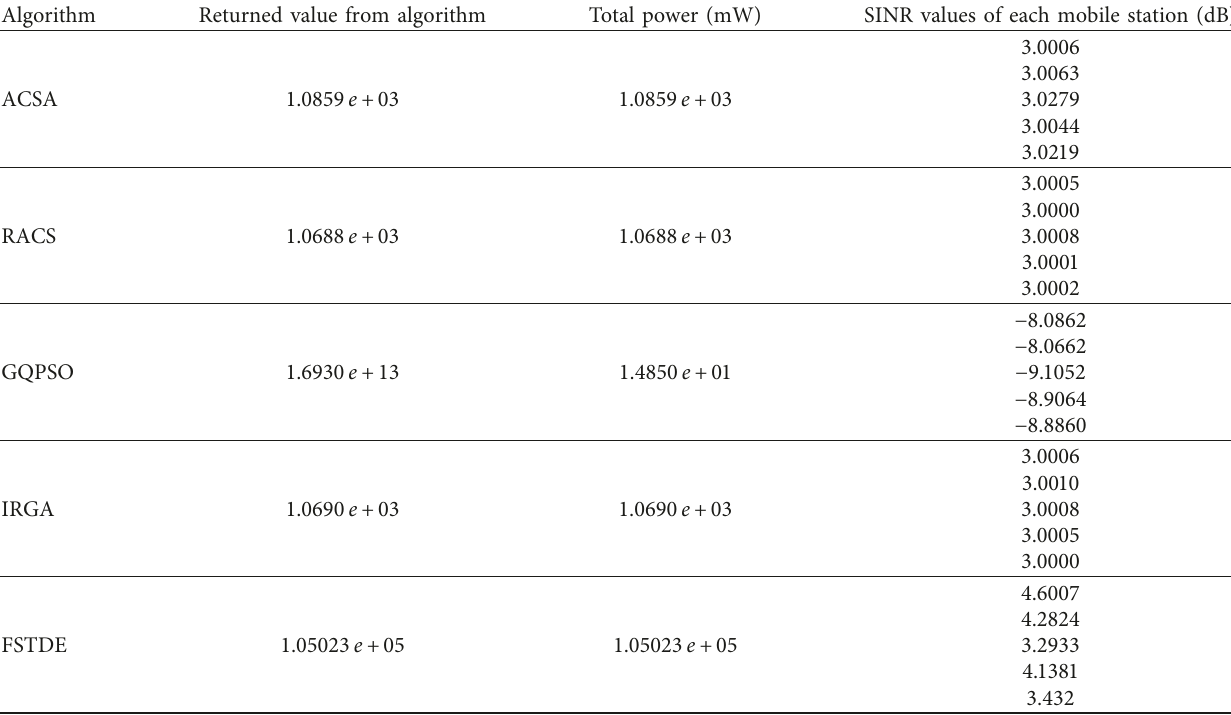
Table 10: Returned results of ACSA and other advanced optimization algorithms for scenario 1.